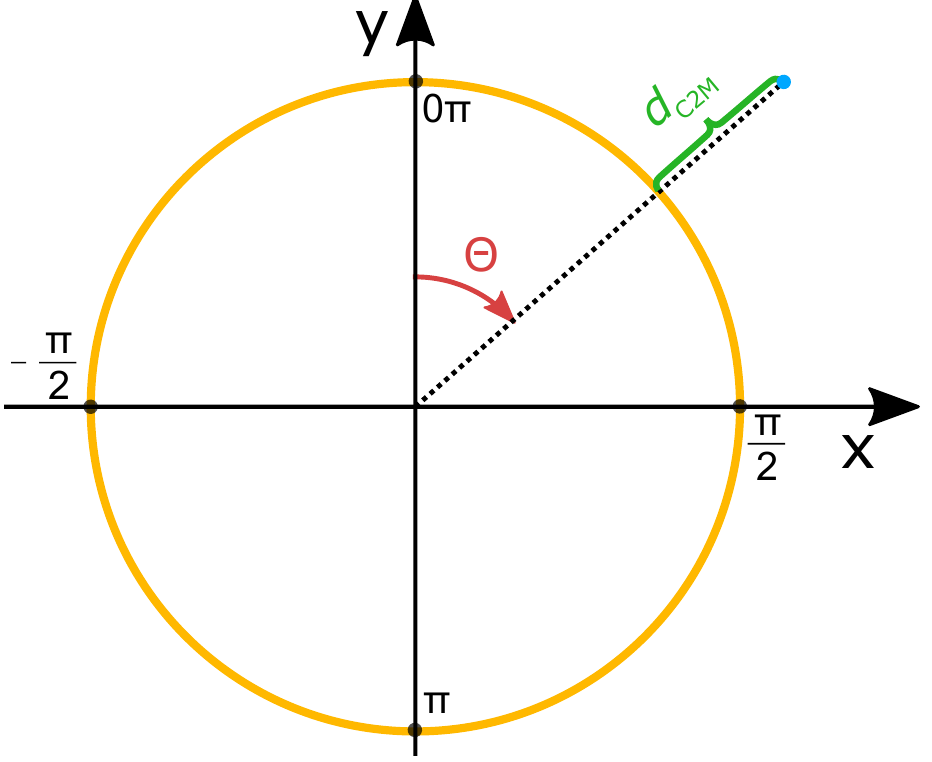
Figure 12. Illustration of the 3D to 2D mapping of the cylinder. The cross section of the cylinder is seen from the XY -plane. The angle θ is mapped onto the y -axis of the two-dimensional plots. The mapping of the cloud-to-mesh reconstruction error from the laboratory and outdoor experiments are shown in Figures 13 and 14, respectively. The figures show the reconstruction of a single depth frame for a range of illuminance levels. The depth frames are not cherry-picked but programmatically selected from a range of frames after an initial warm-up of the depth sensors. As seen from the mean reconstruction error and the number of depth points from Figure 11, the Realsense-Off camera is the only camera configuration to be significantly affected by the absence or presence of light. For this reason, a range of four illuminance levels is visualized for the Realsense-Off camera and only two illuminance levels for the Realsense-On and pico flexx cameras,